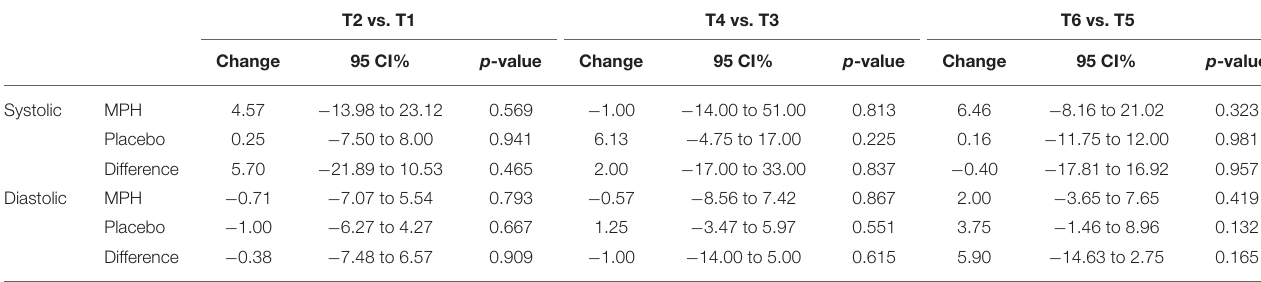
TABLE 4 | Blood pressure